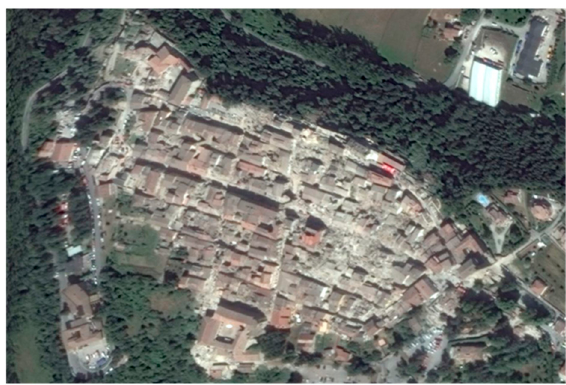
Figure 8. Amatrice historical center, post-earthquake damage from RGB VHR DigitalGlobe image.